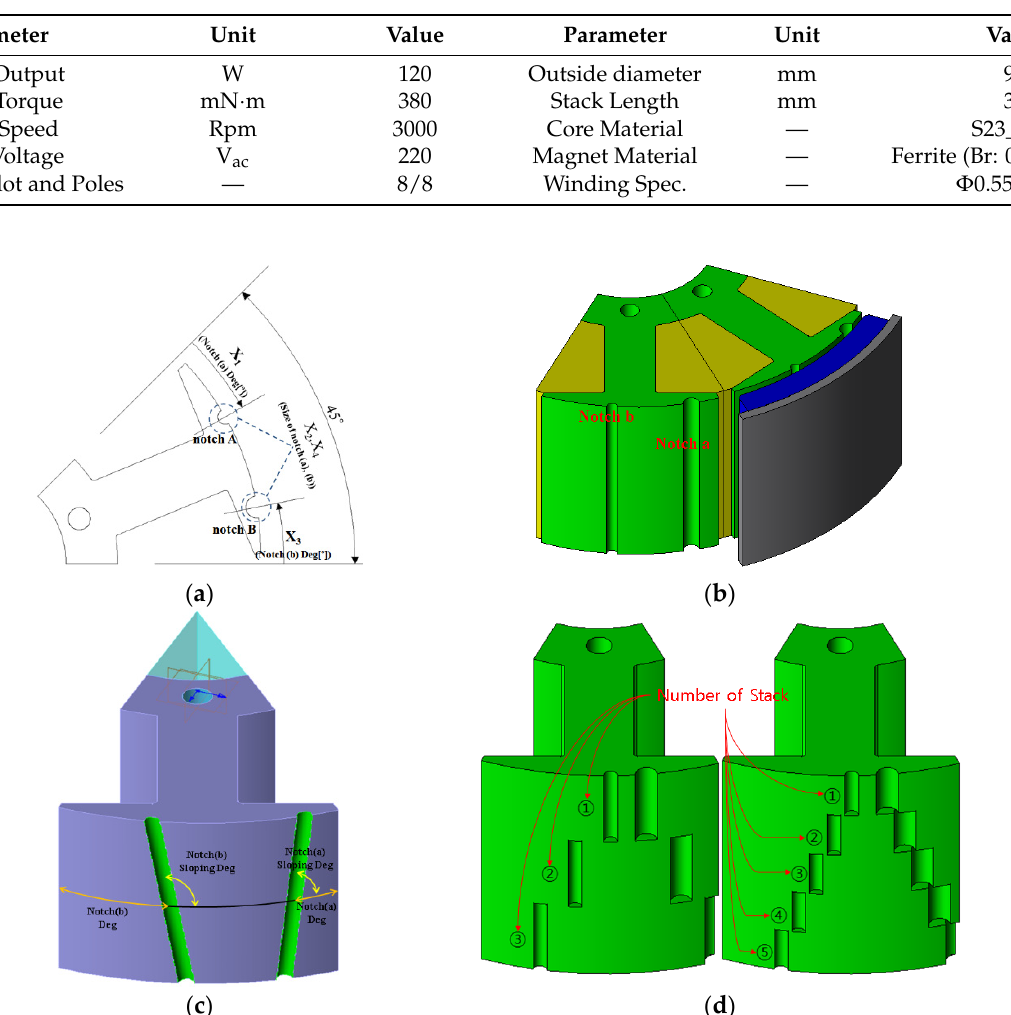
Table 1. Specifications of the single-phase BLDC motor.